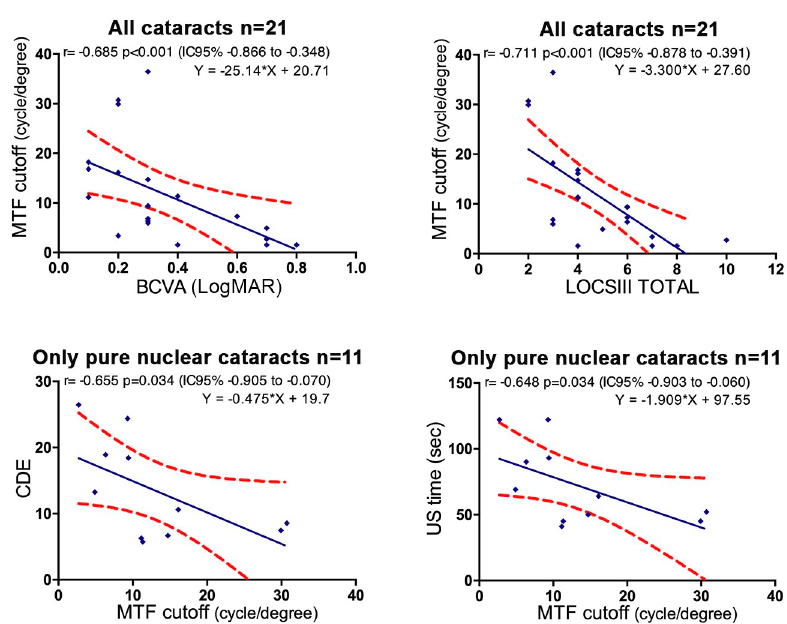
Fig 5. Linear regressions between MTF cutoff and clinical or surgical parameters. Red dots show the 95% CI of the slope and intercept. MTF = Modulation Transfer Function, BCVA = far logMAR best-corrected visual acuity, LOCS III = lens opacity classification system III, CDE = cumulative dissipated energy, US =